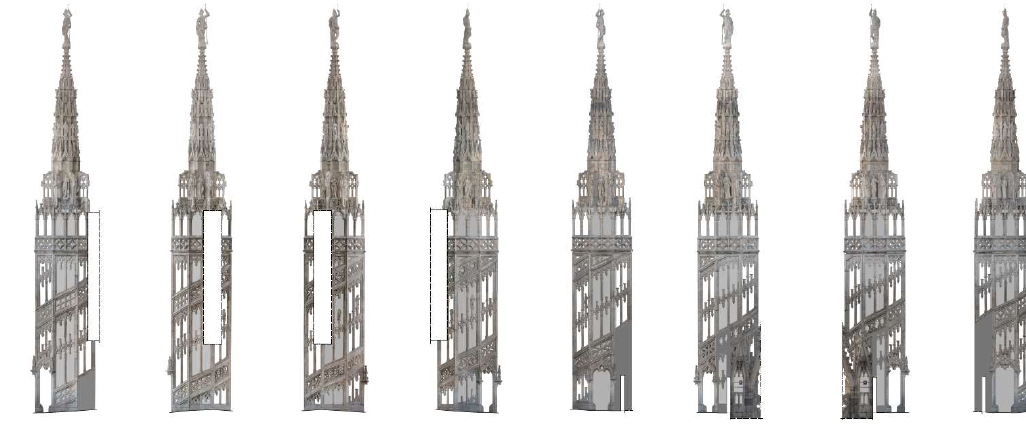
Figure 11. The 8 orthophotos of the sides of the Amadeo’s spires at 1:10